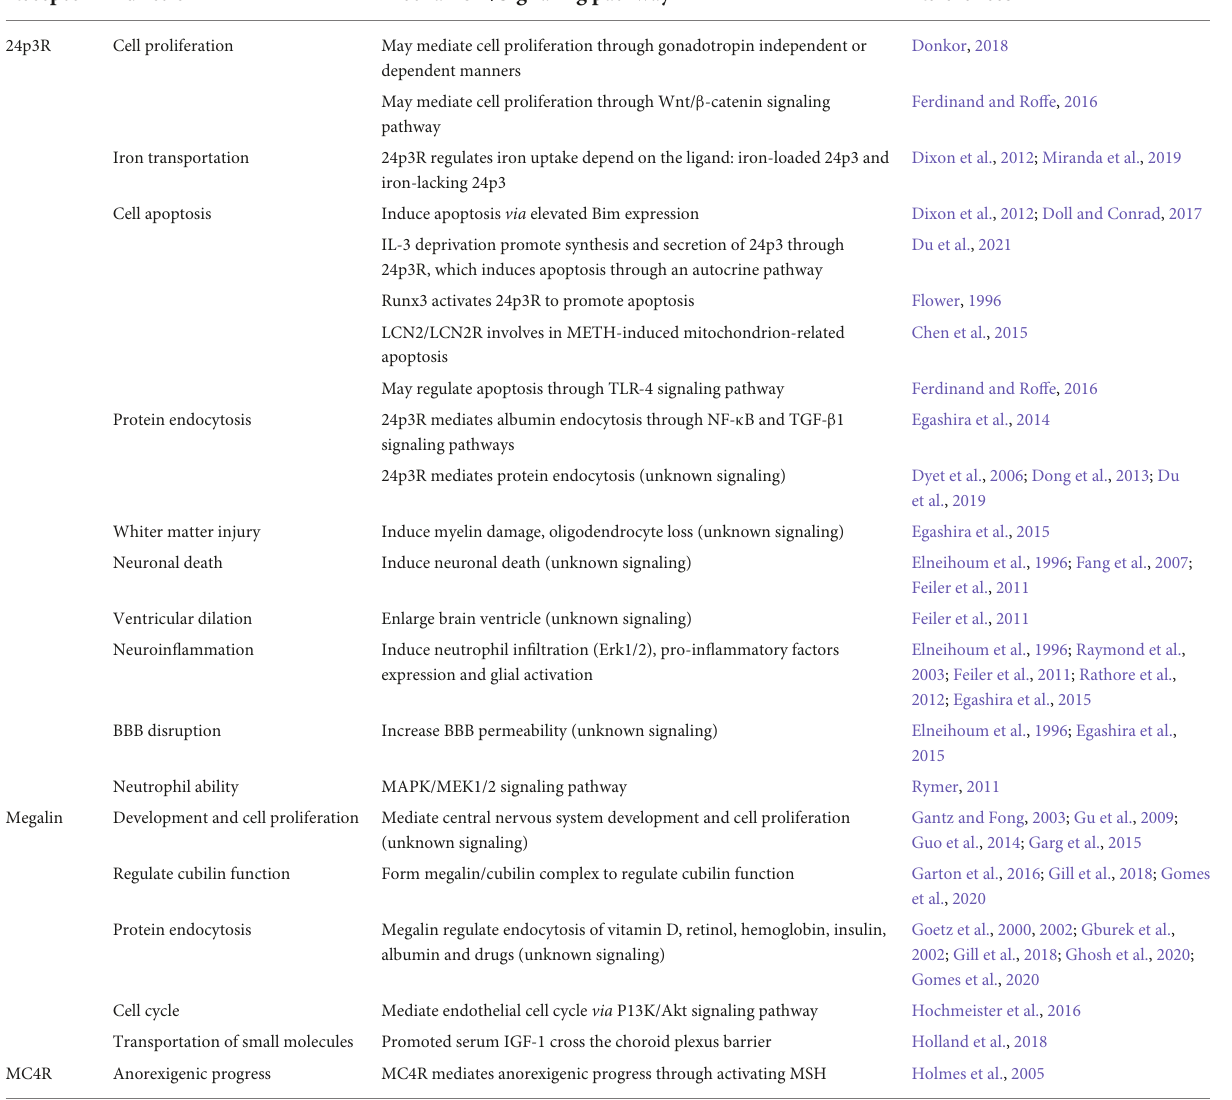
TABLE 1 Function and mechanism of LCN2